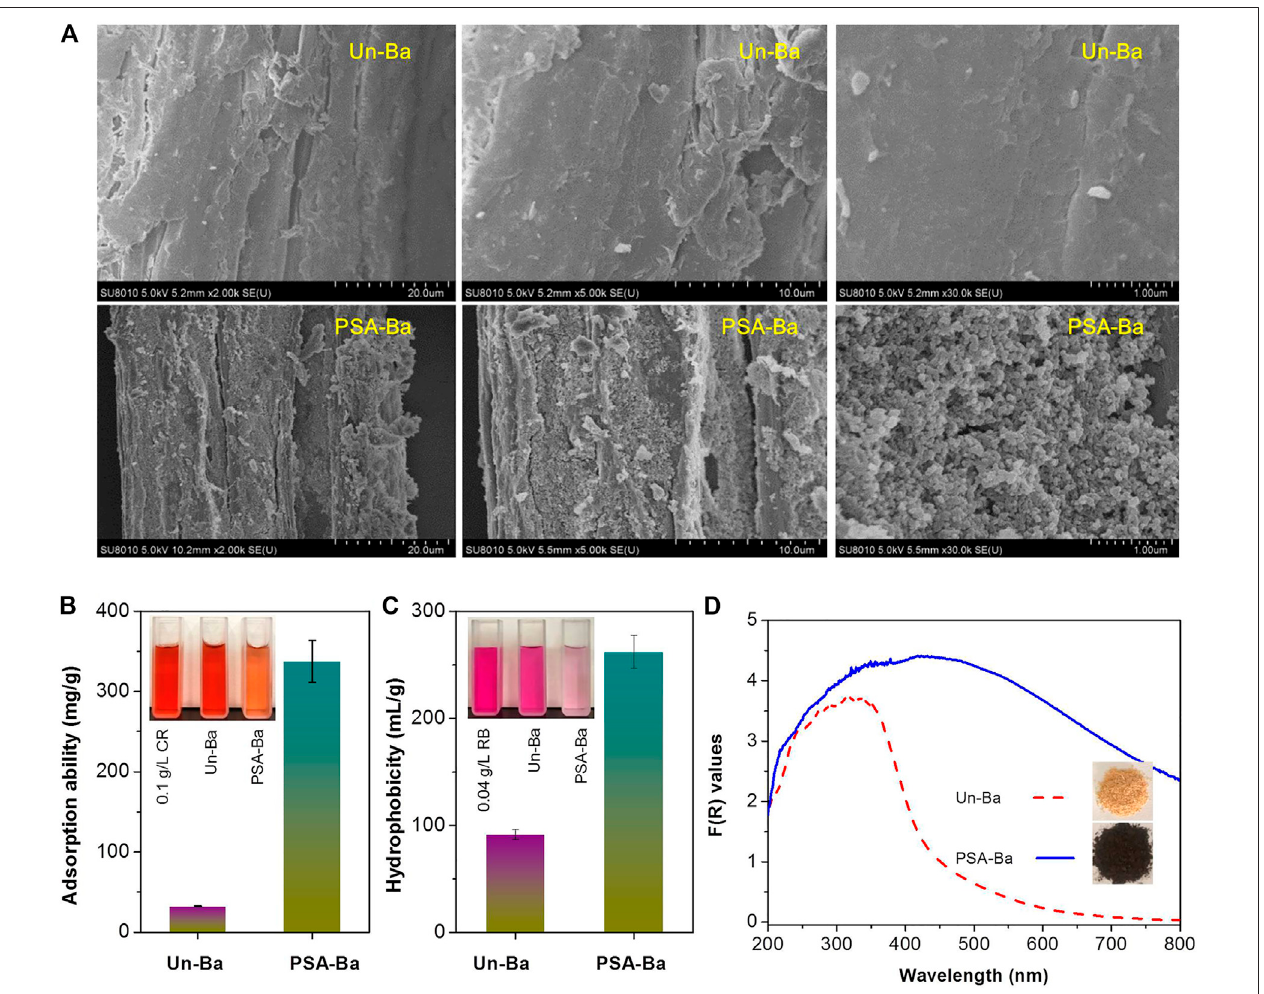
FIGURE 2 | (A) SEM images, (B) accessibility, (C) hydrophobicity and (D) F(R) values of Un-Ba and PSA-Ba substrate. F(R) values were calculated based on the measured sample re fl ectance (%) and Kubelka-Munk function ( Eq. 2 ). CR and RB shown in Figure 2B are the abbreviations of Congo red and Rose Bengal,